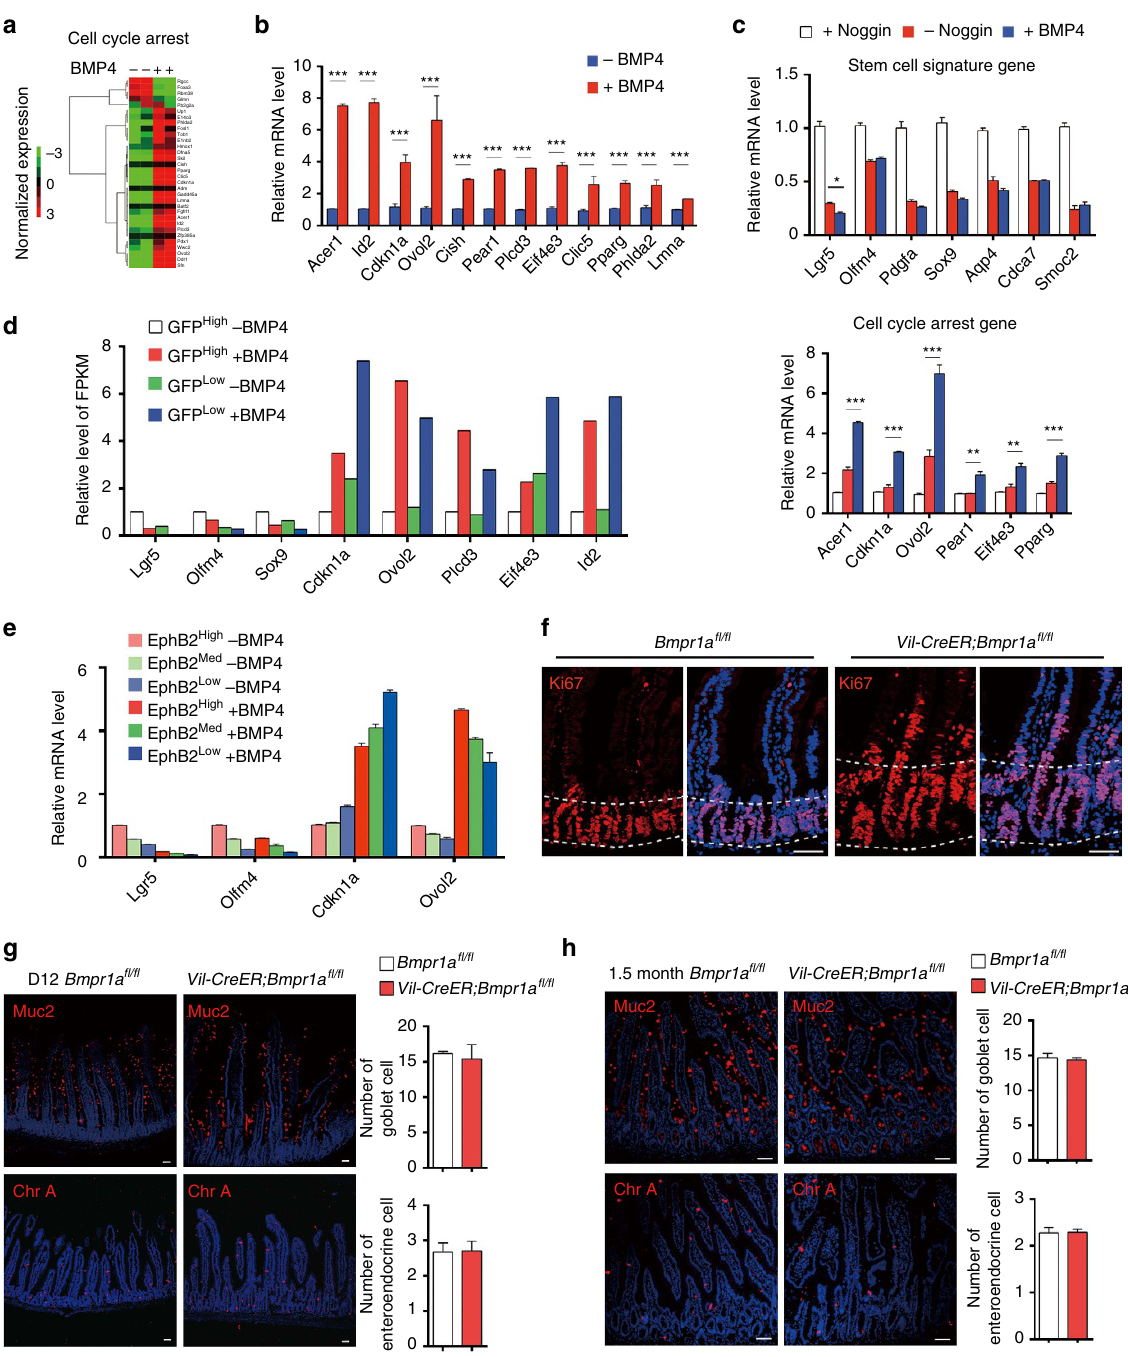
Figure 6 | Low BMP activity restricts the self-renewal of Lgr5 þ stem cells through modulating stem cell signature genes but not cell cycle arrest genes. ( a ) BMP-regulated genes in Lgr5 þ stem cells after 4h BMP stimulation were grouped into cell cycle arrest cluster. ( b ) The expression of the selected genes in the cell cycle arrest cluster were validated by quantitative RT–PCR in Lgr5 þ stem cells sorted from intestinal organoids. Data represent mean ± s.e.m of three independent experiments. ** P o 0.01, *** P o 0.001 by Student’s t -test. ( c ) The expression of the stem cell signature genes and cell cycle arrest genes were measured by quantitative RT–PCR in intestinal organoids from indicated groups after passaging. Data represent mean ± s.e.m of three independent experiments. * P o 0.05, ** P o 0.01, *** P o 0.001 by Student’s t -test. ( d ) Relative level of FPKM of indicated genes from Lgr5-GFP high and Lgr5-GFP low cells with or without BMP treatment for 4h. ( e ) The expression of the stem cell signature genes and cell cycle arrest genes were measured by quantitative RT–PCR in EphB2 high , EphB2 medium and EphB2 low cells sorted from intestinal organoids treated with or without BMP4 for 4h. Data represent mean ± s.e.m of three independent experiments. ( f ) Immunofluorescence staining of Ki67 in Bmpr1a fl/fl and Vil-CreER;Bmpr1a fl/fl mice at day 12. Dotted lines delineate the region of crypts. Nuclei were counter-stained with 4 0 ,6-diamidino-2-phenylindole (DAPI). Images are representative of n ¼ 6 mice per genotype. ( g , h ) Muc2 immunofluorescence staining and chromogranin A immunofluorescence staining in intestine from Vil-creER;Bmpr1a fl/fl and Bmpr1a fl/fl mice at day 12 ( g ) and 1.5 month after induction ( h ). Nuclei were counter-stained with DAPI. Images are representative of n ¼ 6 mice per genotype. Quantifications of goblet cell and enteroendocrine cell number are shown aside. Data represent mean ± s.e.m of n ¼ 5 mice per genotype. Scale bars, 50 m m. NATURE COMMUNICATIONS|8:13824|DOI: